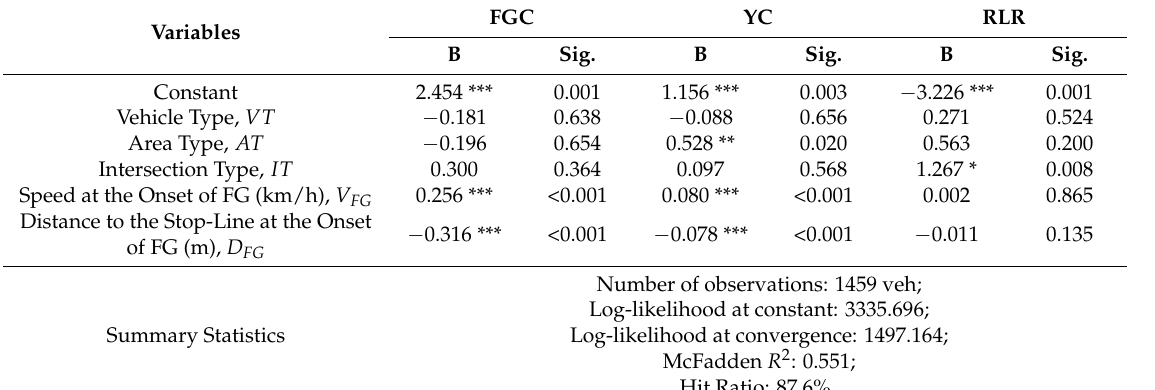
Table 3. MNL model estimation results for the prediction of stop-line crossing